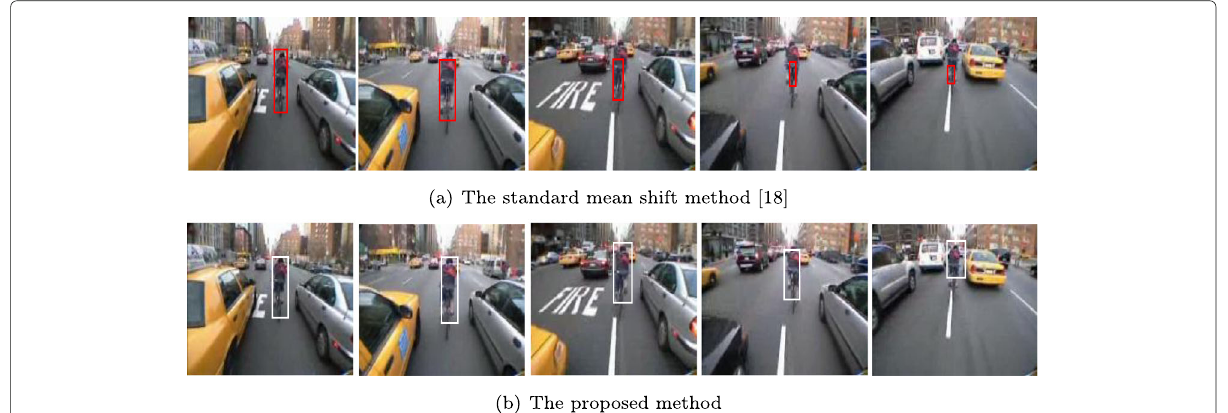
Fig. 2 Tracking results on riding video sequence for frames of 0, 99, 213, 251, 319. a The standard mean shift method [18]. b The proposed